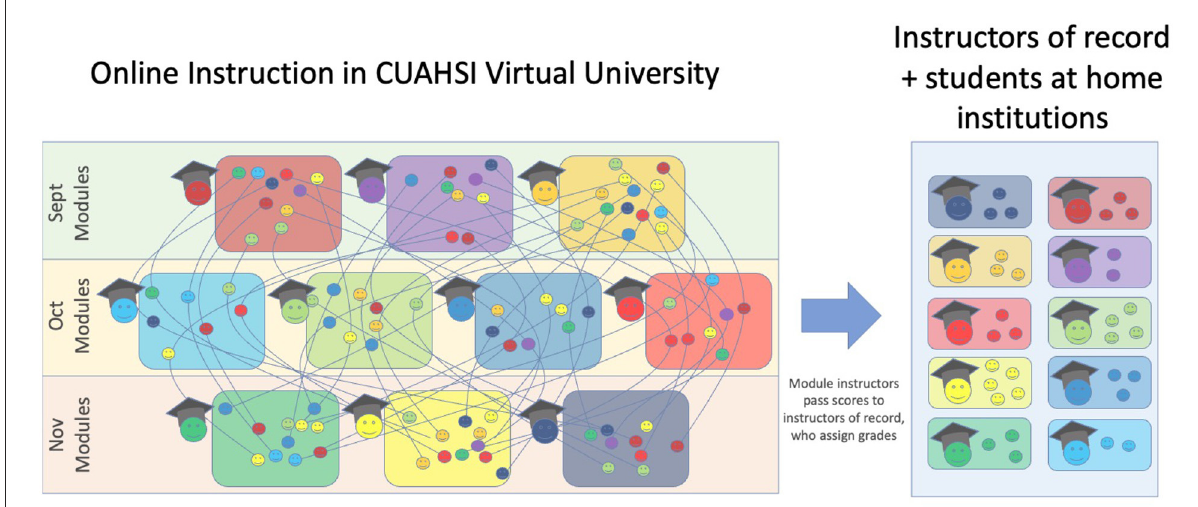
FIGURE1 Instructors from participating universities teach month-long modules online to students (circles) from different institutions (represented by colors). Students choose the modules that interest them, resulting in differentiated instruction of content over the semester, as represented by the thin lines connecting the student icons. After the semester is over, module instructors pass scores to the instructors of record at each participating university, and these instructors assign grades to students from their home